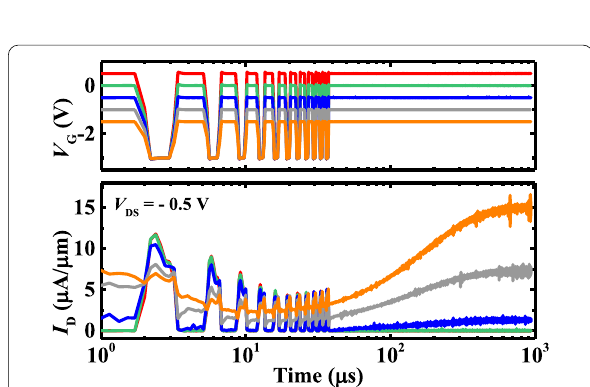
simulated biological memory. The error bars reflect the standard deviation when repeating the measurement a few times to prove the correctness of the data and mini- mize fluctuations in data.